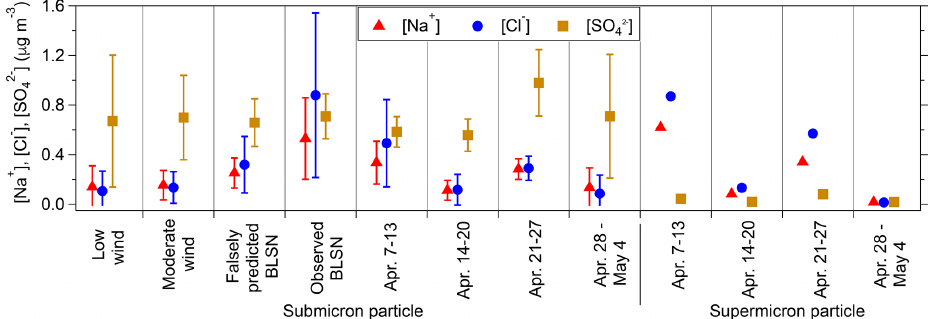
− ] bulk mass concentrations for daily submicron ( < 1 . 1µm d a ) particle samples during Figure 4. Average ( ± 1 σ ) [Na + ], [Cl − ], and [SO 2 4 low wind, moderate wind, falsely predicted BLSN, and observed BLSN periods and for multi-day supermicron (1.1–10µm d a ) particles collected on 7–13 April (65% observed BLSN, 35% falsely predicted BLSN), 14–20 April (9% observed BLSN, 29% falsely predicted BLSN, 58% moderate wind, 4% low wind), 21–27 April (3% observed BLSN, 23% falsely predicted BLSN, 47% moderate wind, 27% low wind), and 28 April–4 May (66% moderate wind, 34% low wind). The submicron particle mass concentrations (average ± 1 σ ) during the four supermicron particle collection periods are also shown for comparison. The corresponding values for these ions as well as [Ca 2 + ], [Mg 2 + ], [NH + ], [K + ], [NO − ], [Br − ], methanesulfonate [CH 3 SO − ], and oxalate (C 2 O 2 − ) can be found in Tables S1 and 4 3 3 4